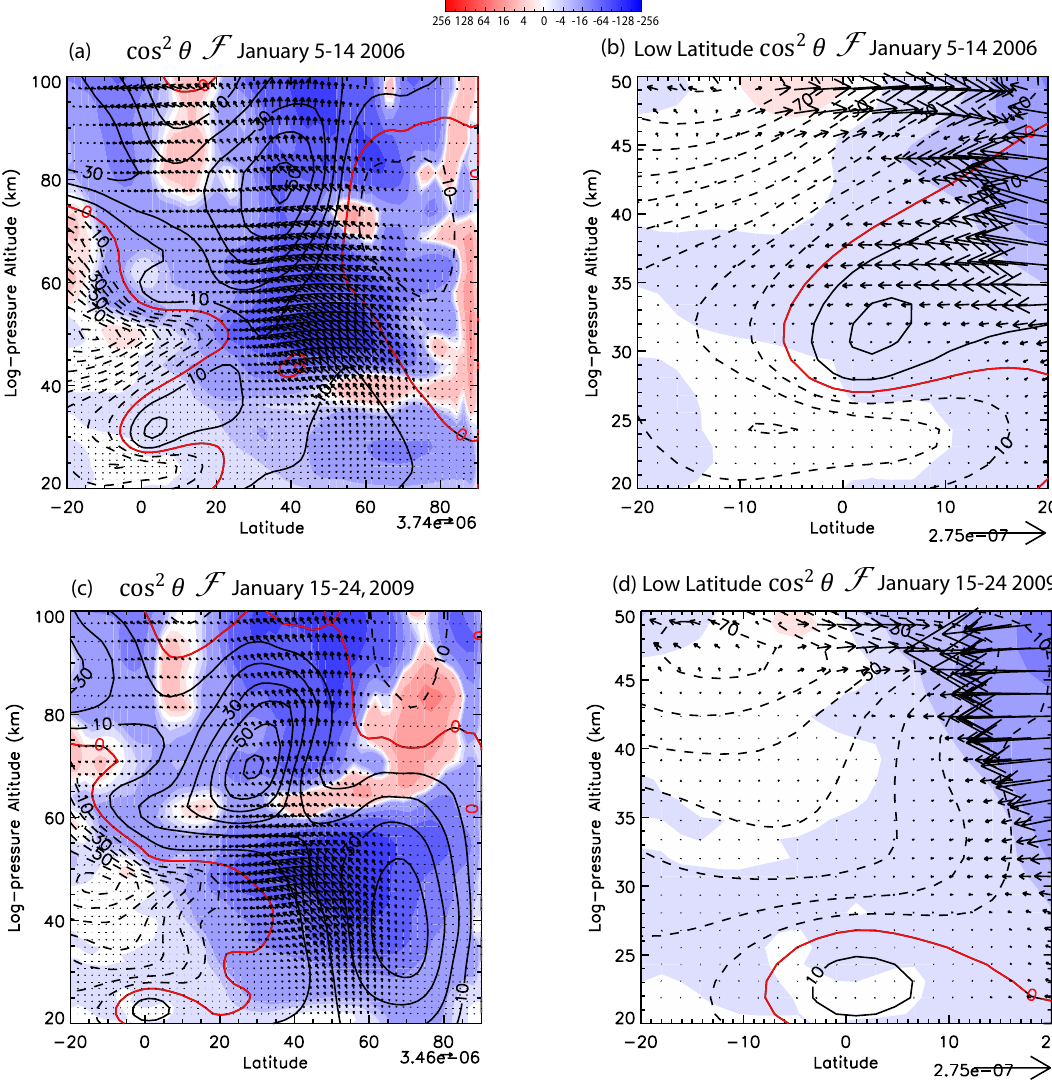
Figure 6. Plot of F 0 vectors superimposed on contours of cos 2 θF , (a) between 20 and 100km and 20 ◦ S to 90 ◦ N averaged over 5– 14 January 2006, (b) between 20 and 50km and 20 ◦ S to 20 ◦ N averaged over 5–14 January 2006, (c) between 20 and 100km and 20 ◦ S to 90 ◦ N averaged over 15–24 January 2009 and (d) between 20 and 50km and 20 ◦ S to 20 ◦ N averaged over 15–24 January 2009. The zonal-mean zonal wind is plotted as black contours (at 10ms − 1 intervals); the red contours indicate the zero wind